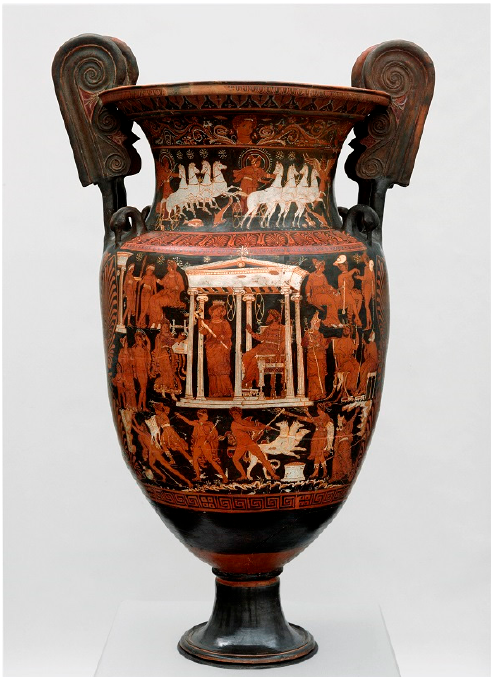
Figure 15. New York, Metropolitan Museum of Art 11.120.3a,b Apulian loutrophoros, Darius Painter, ca. 340–330 B.C. Female head in floral surround emerging from acanthus (lid), female head rising from flower and flanked by floral tendrils (shoulder), male deity (Hades? Zeus?) adjudicating between Persephone and Aphrodite regarding Adonis’ immortality (upper register on body), grave stele between youths and women (lower register on body). Image © The Metropolitan Museum of Art.